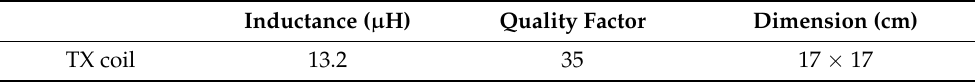
Table 2. Properties of the wireless-charging hanger’s TX